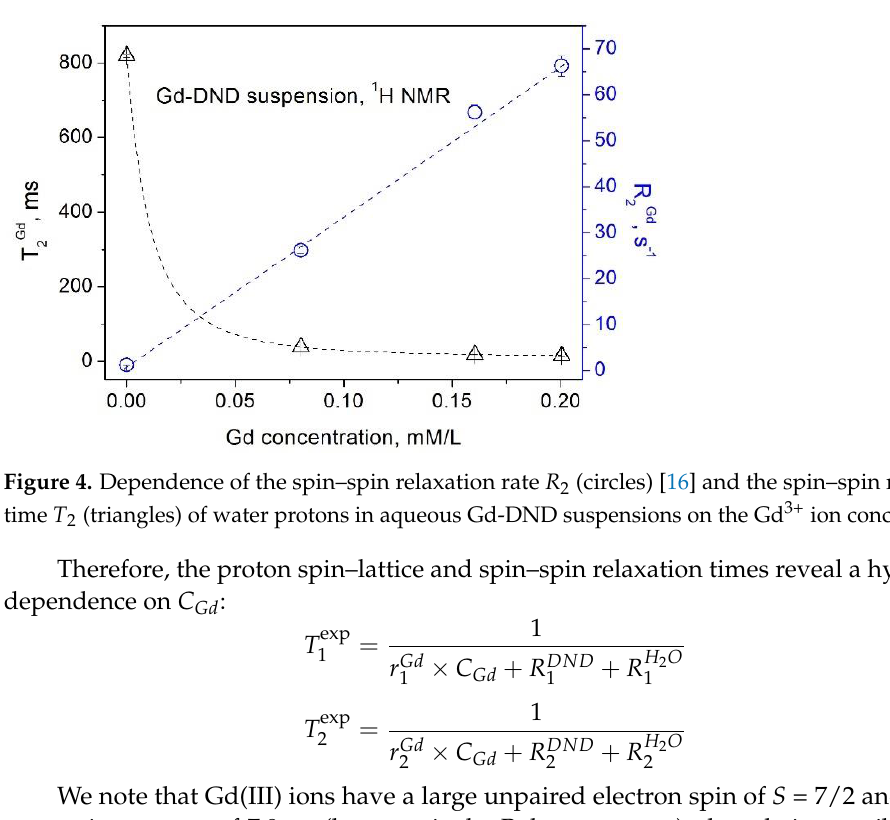
Figure 3. Dependence of the spin – lattice relaxation rate R 1 (circles) [16] and the spin – lattice relaxa- tion time T 1 (triangles) of water protons in aqueous Gd-DND suspensions on the Gd 3+ ion concen- tration.